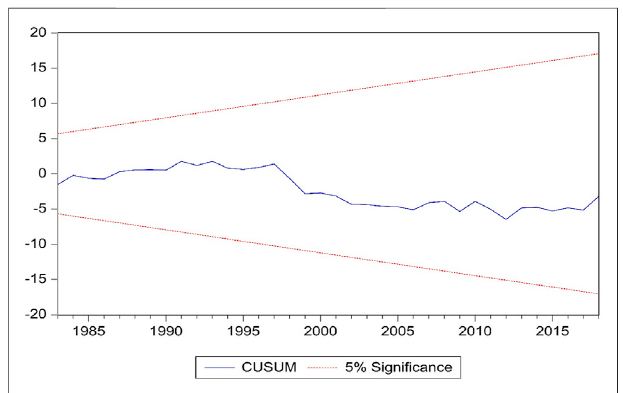
FIGURE 5 | CUSUM plot (model